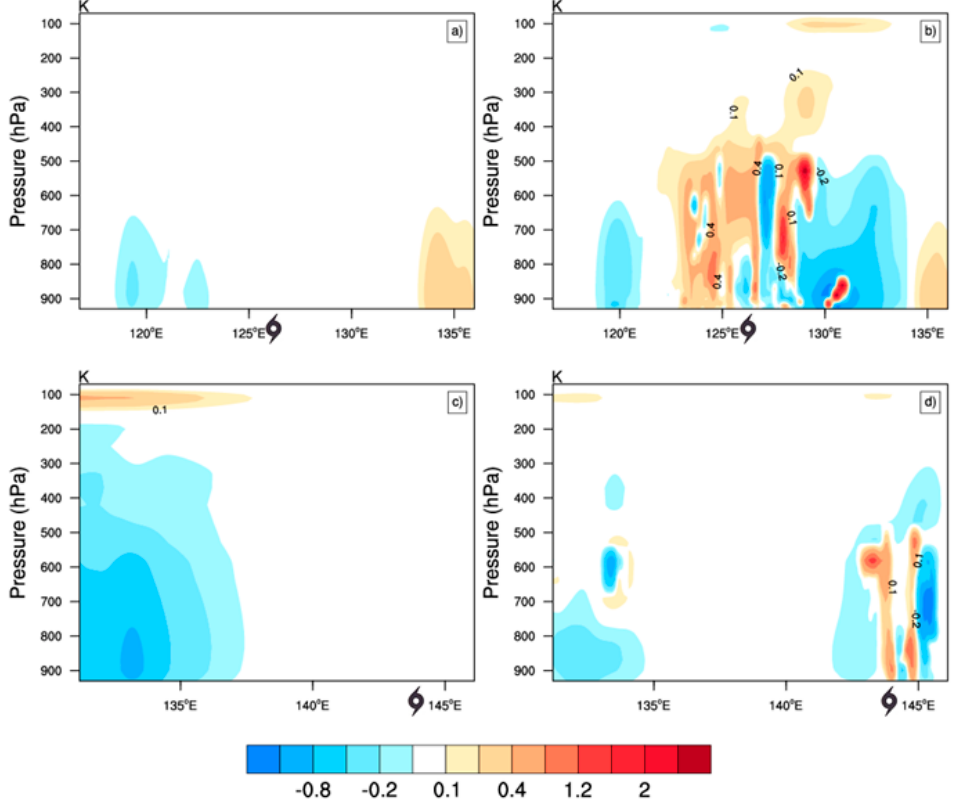
Figure 15. The west–east cross-sections along 25.261° N ( a , b ) and 18.517° N ( c , d ) of temperature difference (K) at 1800 UTC on 9 July from CLEARSKY ( a , c ) and ALLSKY ( b , d ) experiments, with black typhoon mark in the x axis for the longitude of Chan-hom and Nangka.